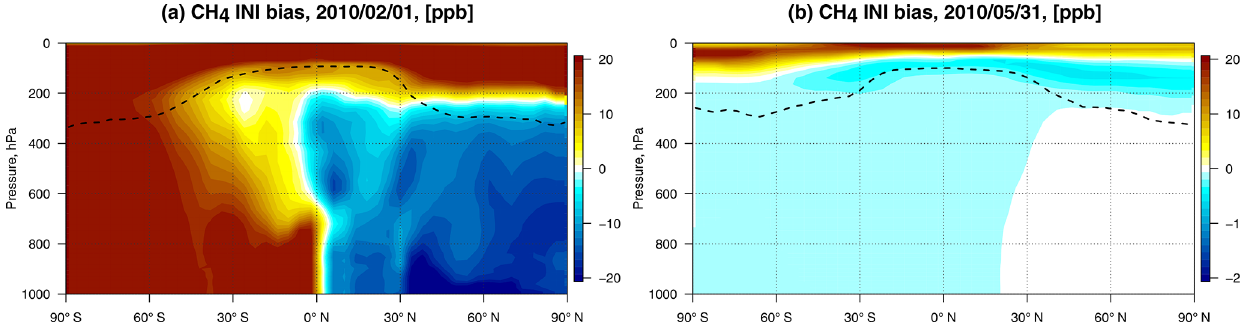
Figure 5. Results of the OSSE with biased initial conditions. (a) A priori bias in initial conditions. (b) A posteriori bias at the end of the assimilation window. The dashed line represents the mean tropopause height on 31 May 2010 taken from GEOS-5 meteorological fields.